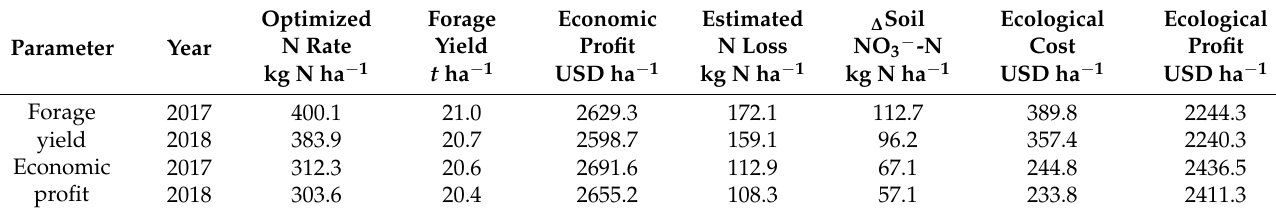
Table 4. The optimal N rate, forage yield, economic profit, estimated N loss, ∆ Soil NO 3 − -N, ecological profit, ecological cost when the forage yield, economic profit or ecological profit is optimized or when soil N is in